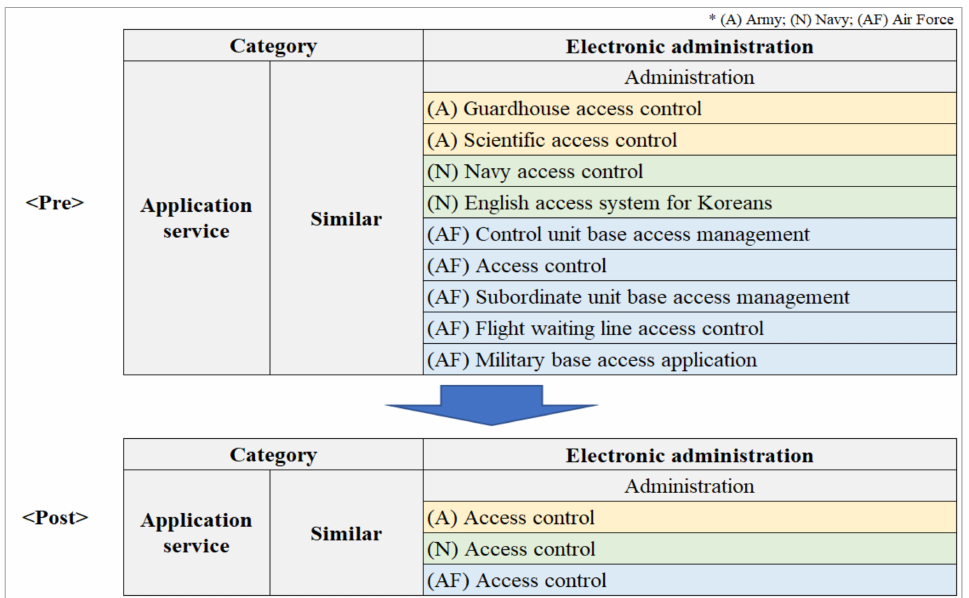
Figure 9. Identification of similar services in the current SaaS portfolio.